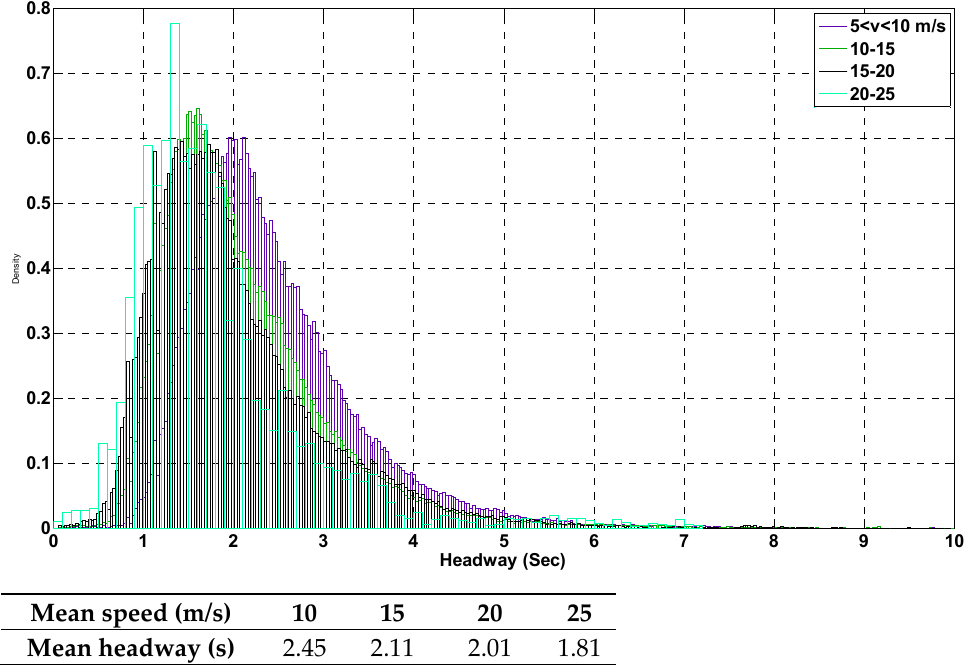
Figure 6. Headway distribution shift to higher values when speed decreases in the NGSIM real data.